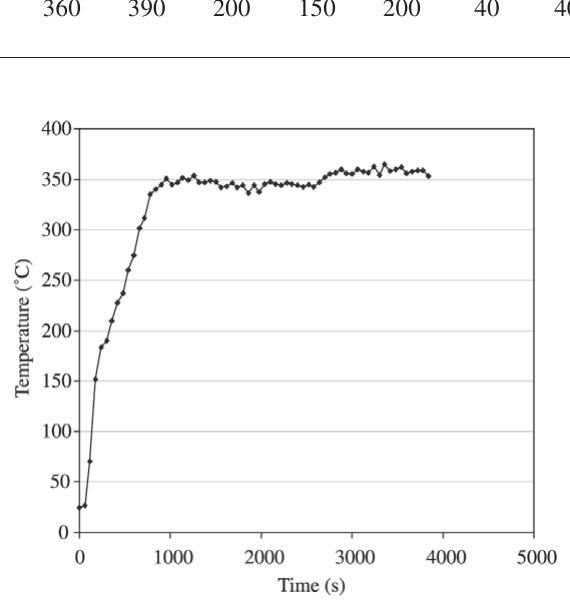
Figure 1. Time-temperature profile for the in situ heat treatments.